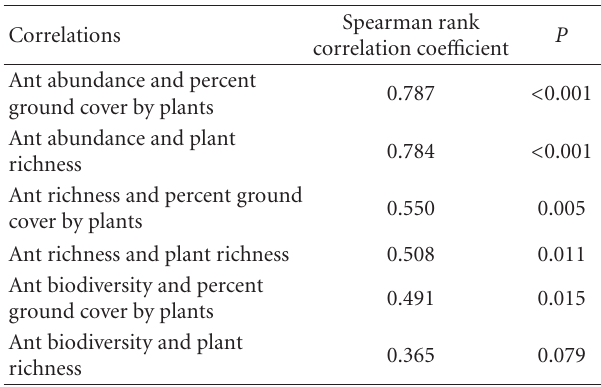
Table 8: Spearman rank-order correlations between ant commu- nity and plant community